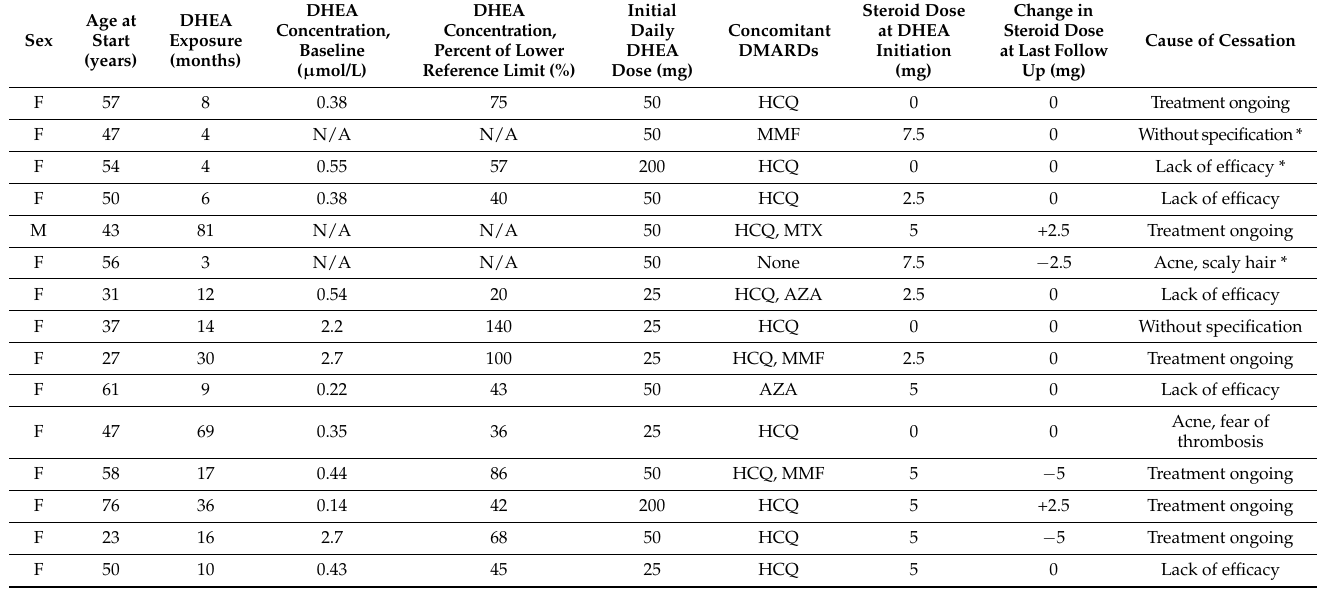
Table 2. Individual descriptions of the 15 patients with SLE exposed to